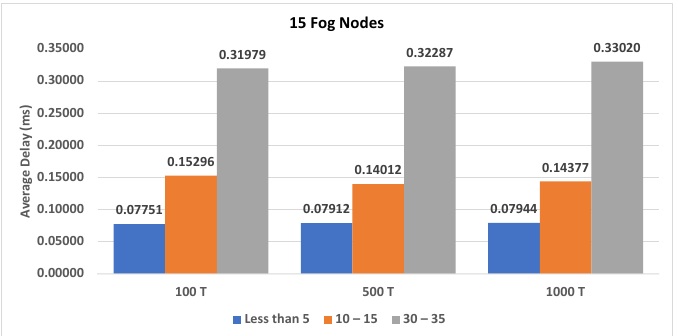
Figure A8. The impact of the different sets of affected transactions on 10 fog nodes.